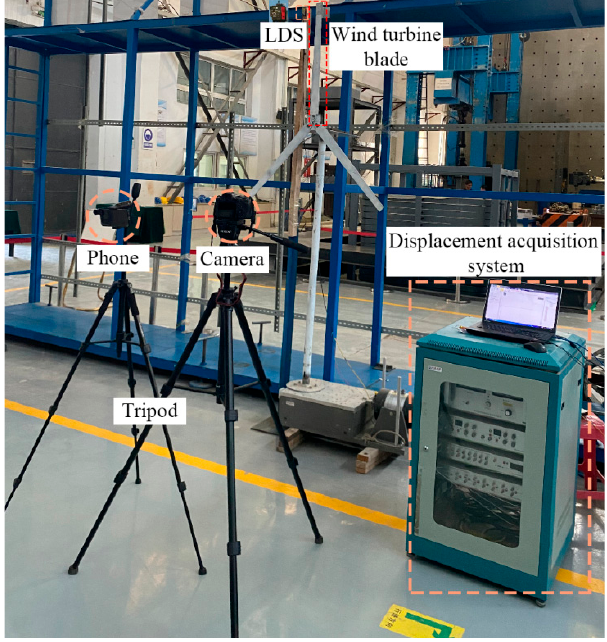
Figure 6. Smartphone displacement monitoring test equipment.